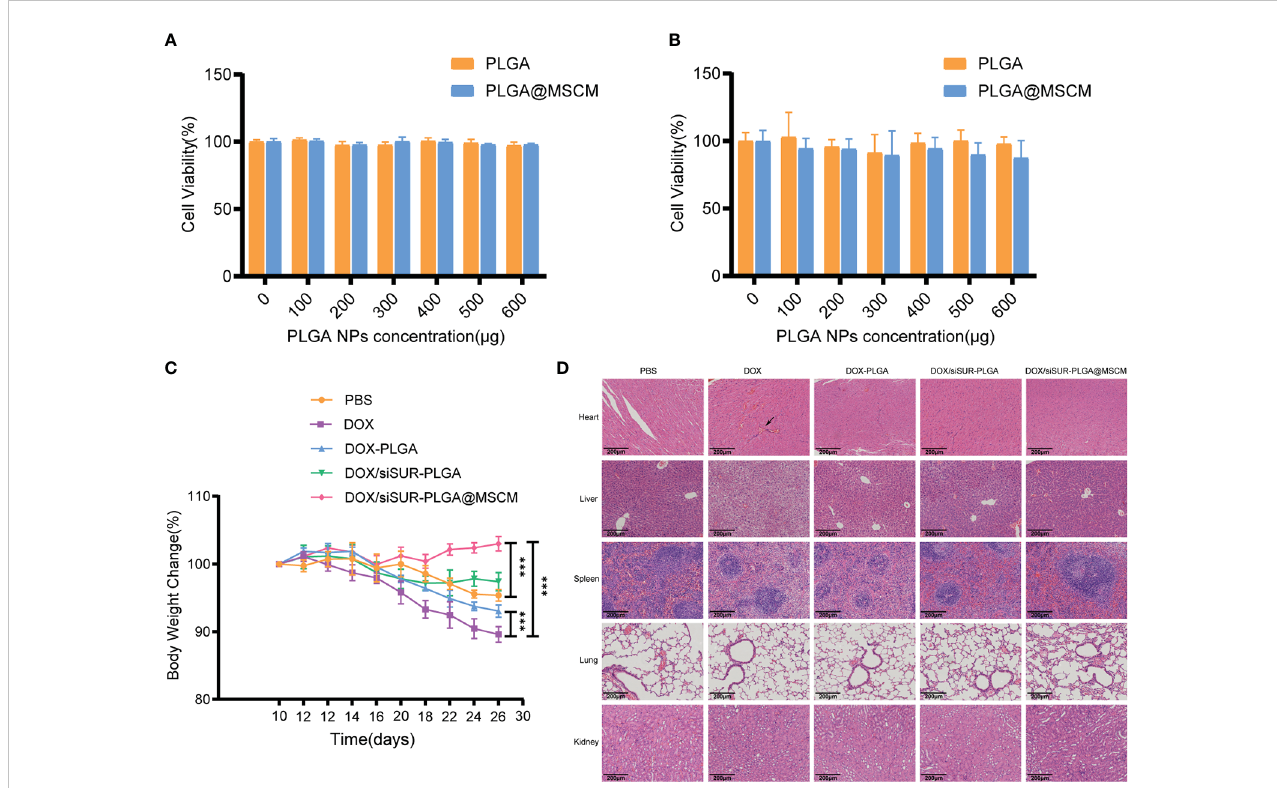
FIGURE 7 In vivo and in vitro biosafety assessment. Cytotoxicity of different concentrations of empty PLGA and empty PLGA@MSCM nanoparticles to MG63 cells, assessed at 24 hours (A) and 48 hours (B) . (C) Changes in body weight in the mice in each group during treatment. (D) H&E staining images of the major organs of mice from different treatment groups. Scale bar, 100 µm. The arrow points to a myocardial vascular lesion. ***p